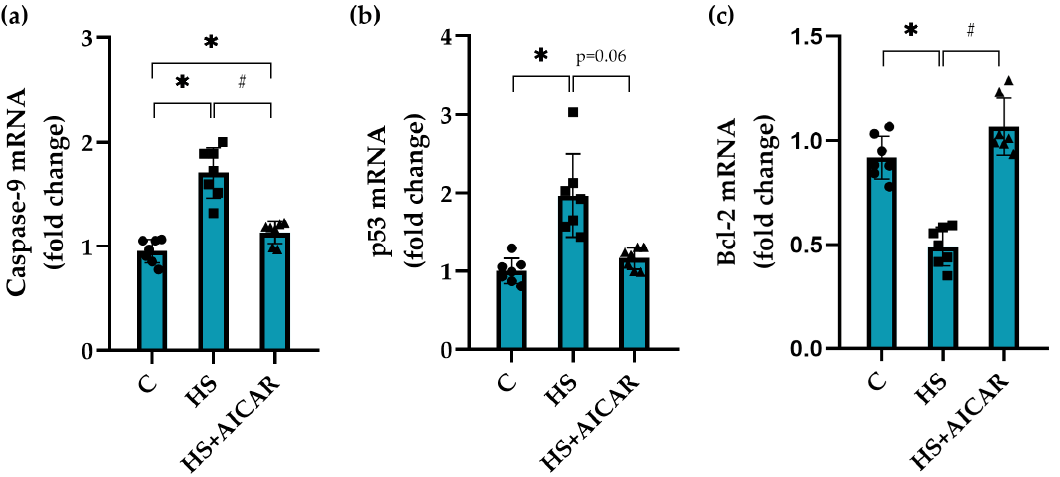
Figure 4. Effect of AICAR treatment on the mRNA expression of ( a ) pro-apoptotic markers ( caspase-9 , ( b ) p53 and ( c ) anti-apoptotic marker ( Bcl-2 ) in differentiating myoblasts derived from the atrophied rat soleus muscle. C—myoblasts derived from rat soleus muscle of the control rats, HS—myoblasts derived from rat soleus muscle after 7-day HS, HS+AICAR—myoblasts derived from rat soleus muscle after 7-day HS and treated with AICAR. Values are means ± SEM, expressed as fold changes vs. C. Dots, squares and triangles on the bars represent individual data points. n = 7, *— p < 0.05 vs. C; #— p < 0.05 vs. HS.